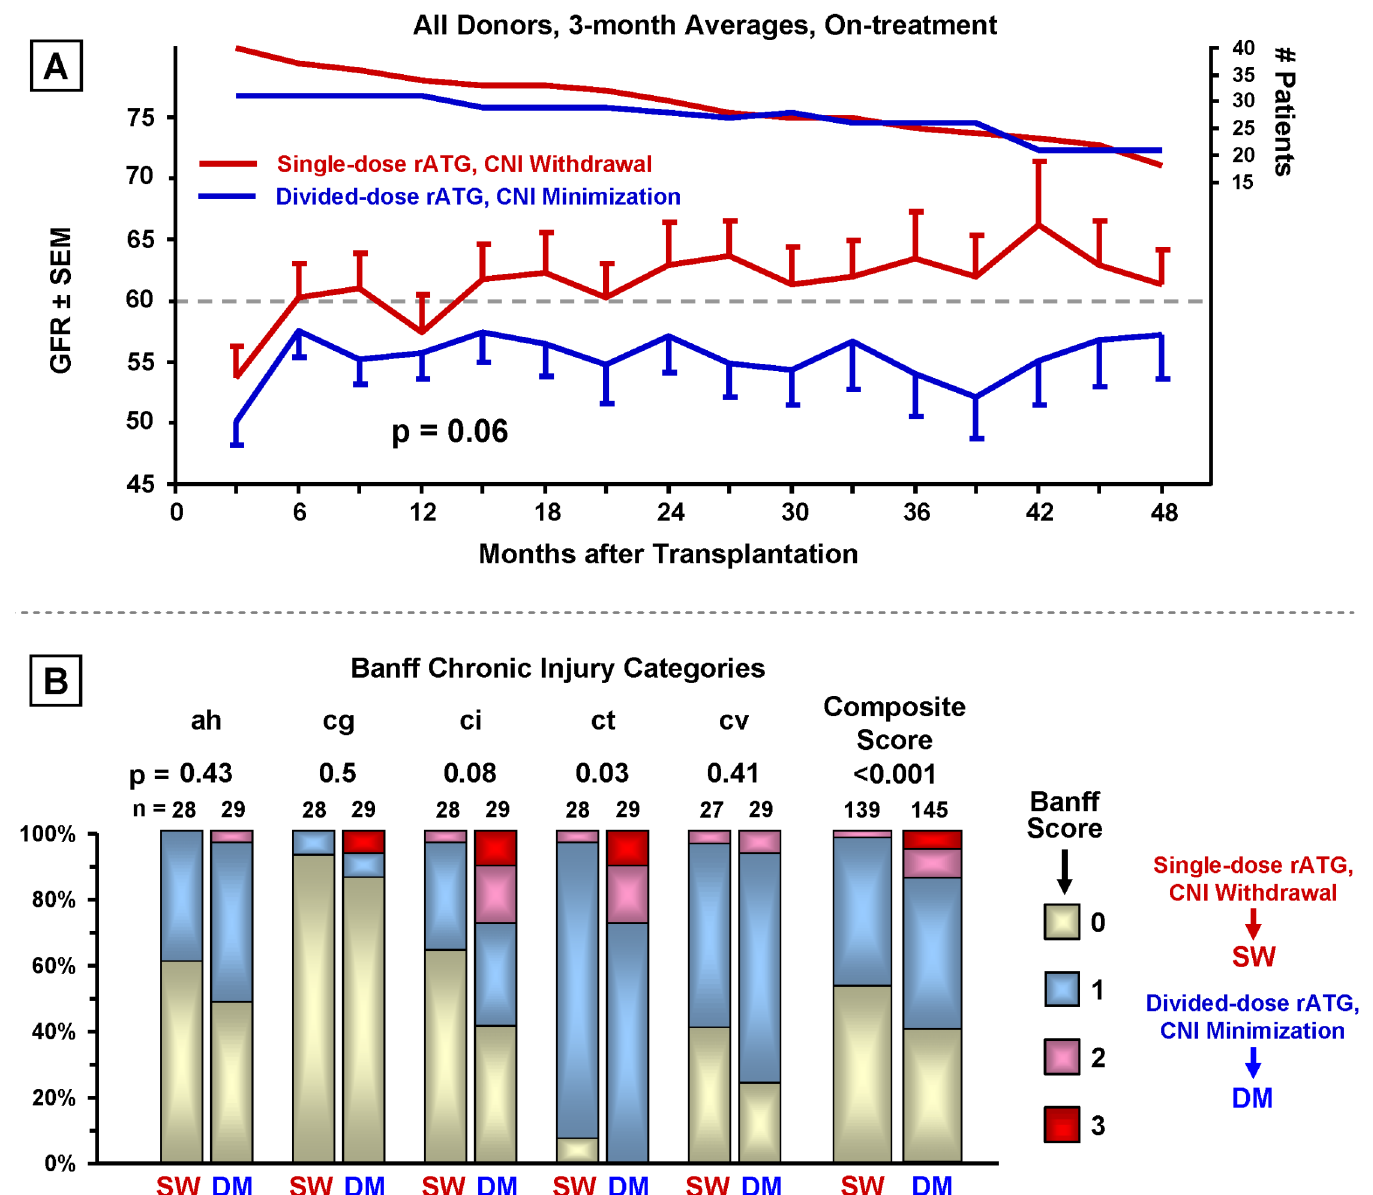
Fig 8. Combined impact of single-dose rATG induction with CNI withdrawal. On-treatment comparison of best and worst treatment combinations (single-dose rATG with delayed CNI withdrawal vs. divided-dose rATG with delayed CNI minimization). (A) Renal function analyzed as in Fig 3. (B) Chronic Banff renal graft histopathology as in Fig